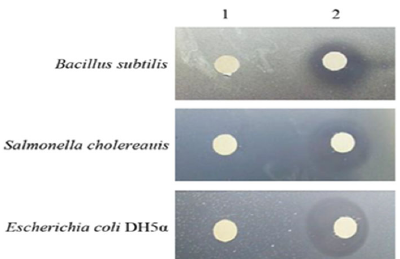
Figure 7. Antibacterial test using the agar diffusion method. An agar diffusion method was used to carry out antibacterial activity analysis. The concentration of 84 ug/mL purified LfcinB was dropped on the indicator bacterial plate. The experimental group has an obviously bacteriostatic circle compared to the buffer alone. The representative results showing LfcinB with bacteriostatic ability for Salmonella choleraesuis (SC) and Salmonella typhimurium (ST) are shown .